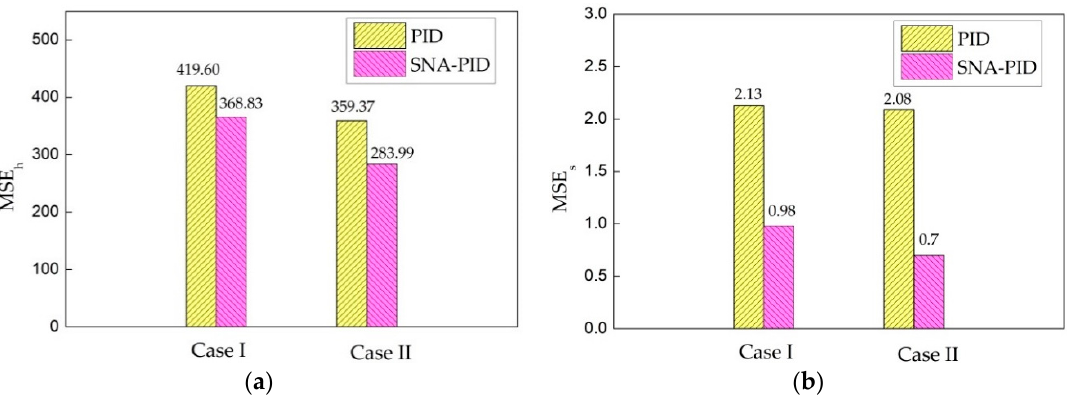
Figure 14. Mean square error (MSE) of the two controllers’ speed tracking. ( a ) The MSE during the whole process; ( b ) the MSE in steady-state.